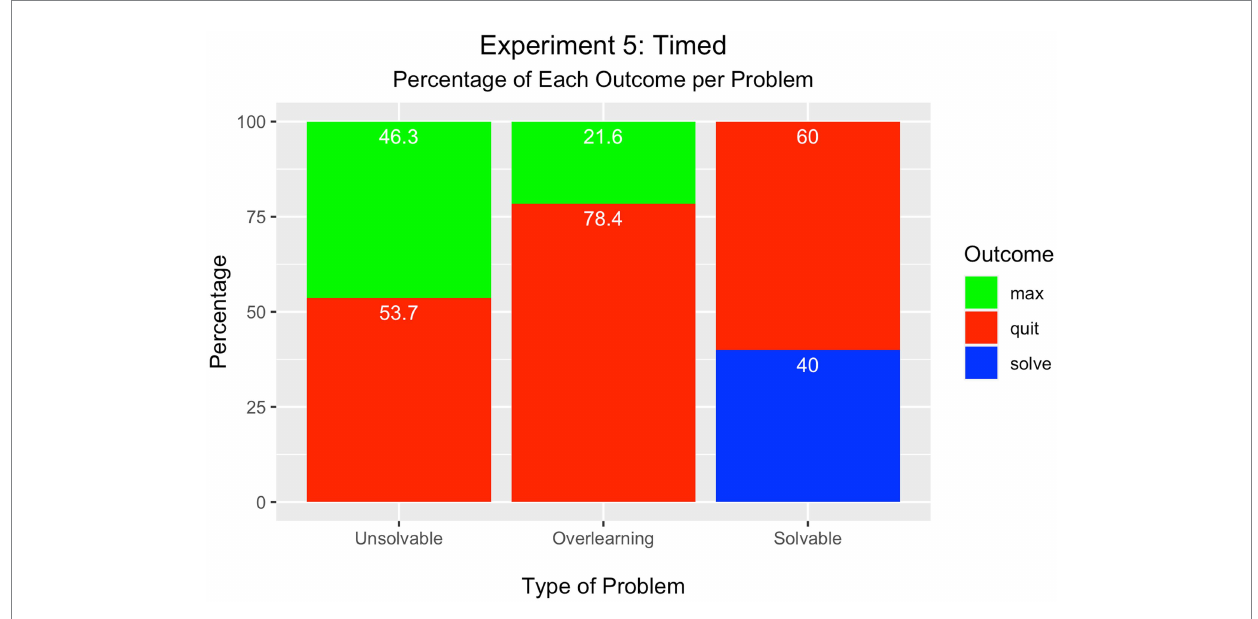
FIGURE 6 Experiment 5 – Timed Completion